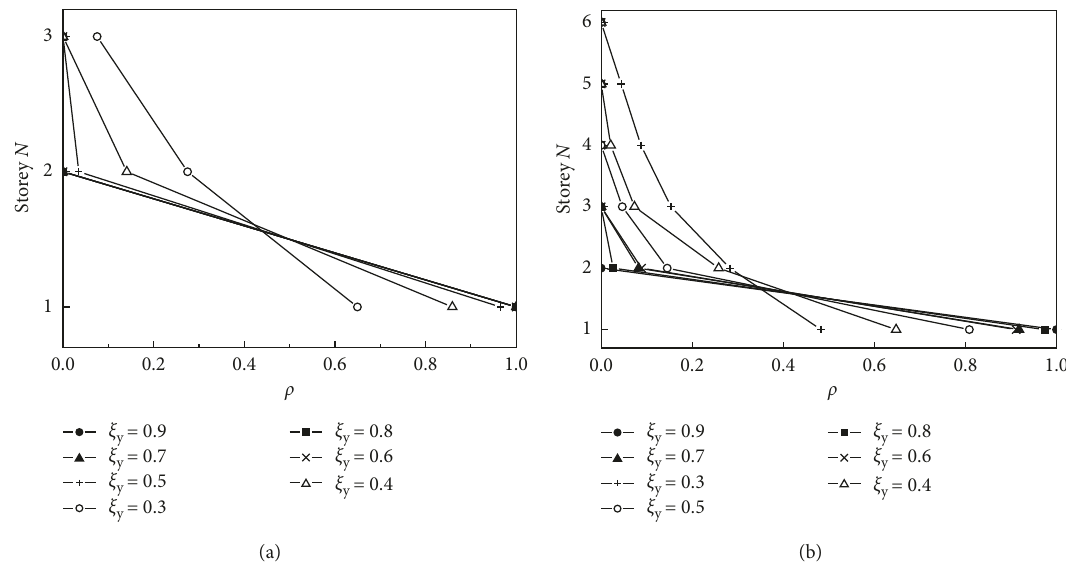
Figure 11: Hysteretic energy ratio ρ � 0.18s, Loma Prieta waves and (b) 6-storey structure, T � 0.45s, San i : (a) 3-storey structure, T Fernando